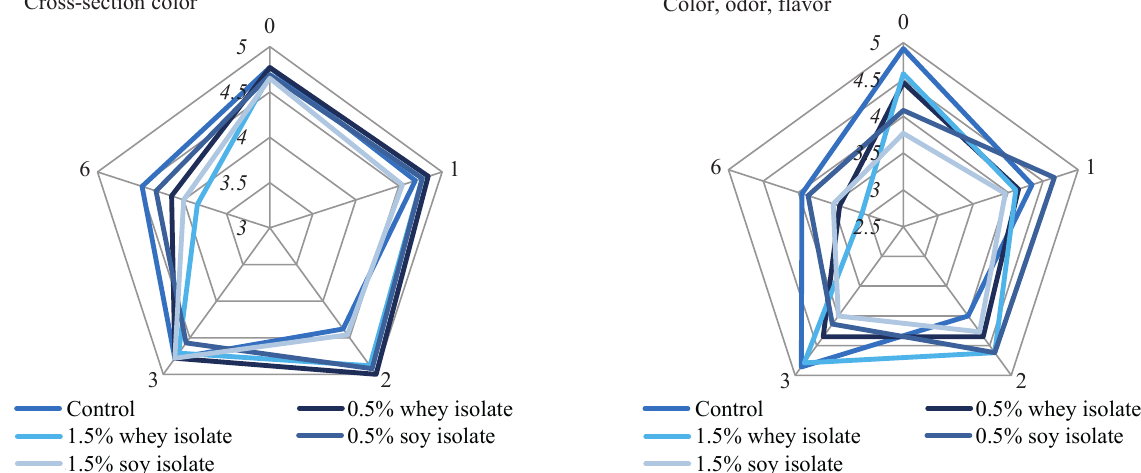
Figure 1 Sensory evaluation of cross-section color, odor, flavor, and taste of sausages with protein